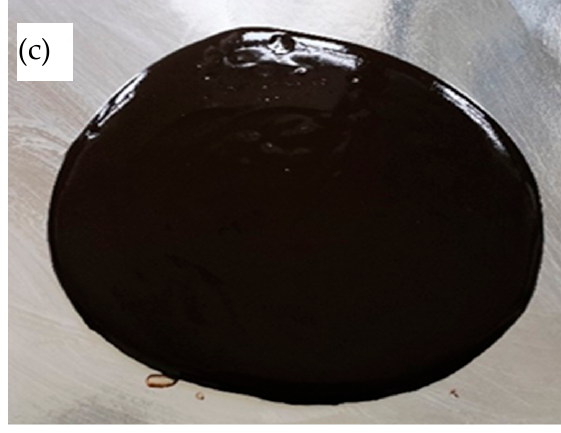
Figure 2. Spread shapes of a sapropel: ( a ) unactivated; ( b ) mechanically activated 1 min; ( c ) mechanically activated 2 min.